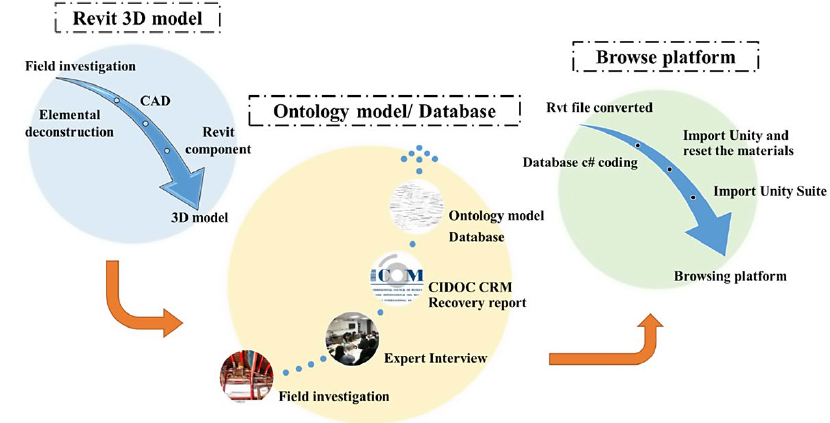
Figure 2. Modeling flow chart, methods and tools